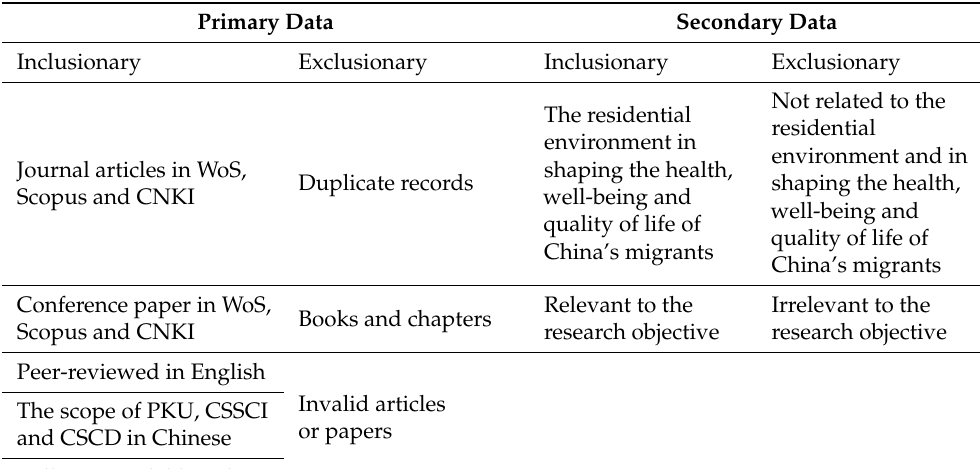
Table 1. Inclusion and exclusion criteria.